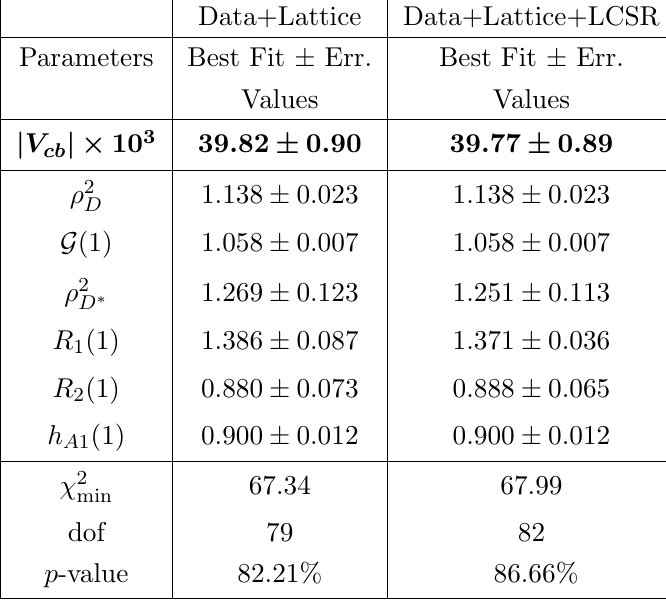
Table 6 . Results of the combined (cid:12)t to the data in B ! D ( (cid:3) ) ‘(cid:23) ‘ with CLN. Param- case-1 case-1 case-2 with with